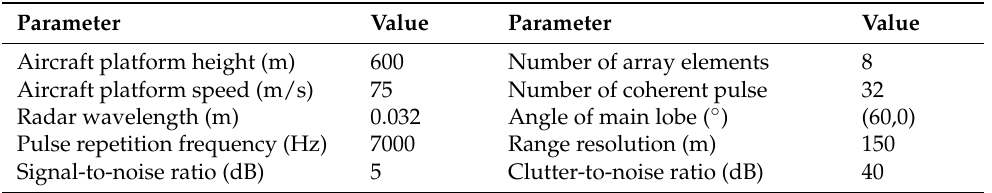
Table 1. System simulation